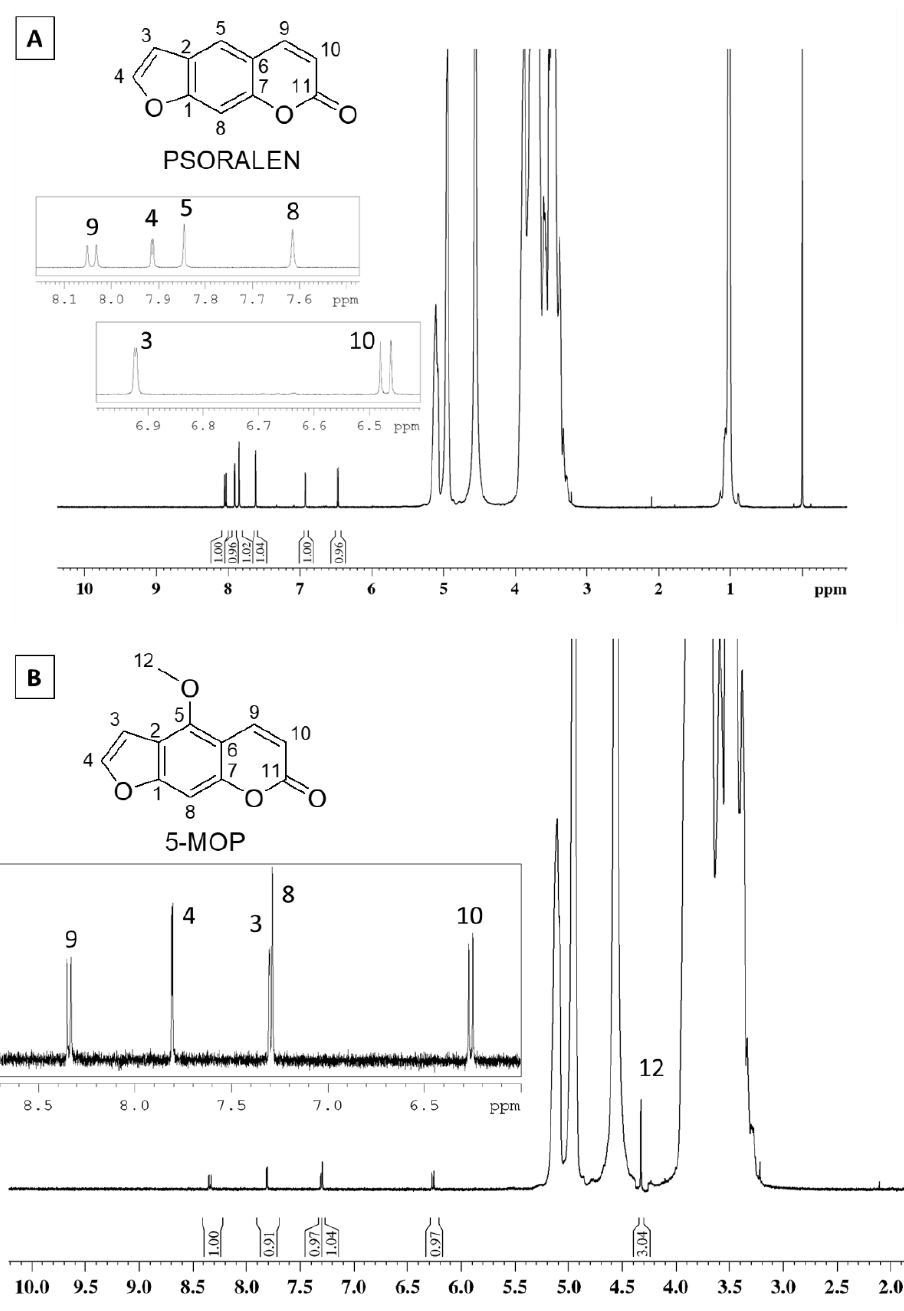
Figure 2. 1 H NMR spectrum of the ( A ) PSO- and ( B ) 5-MOP-HP- β -CD inclusion complex (HP- β -CD 15 Mm, D 2 O, 500 MHz).